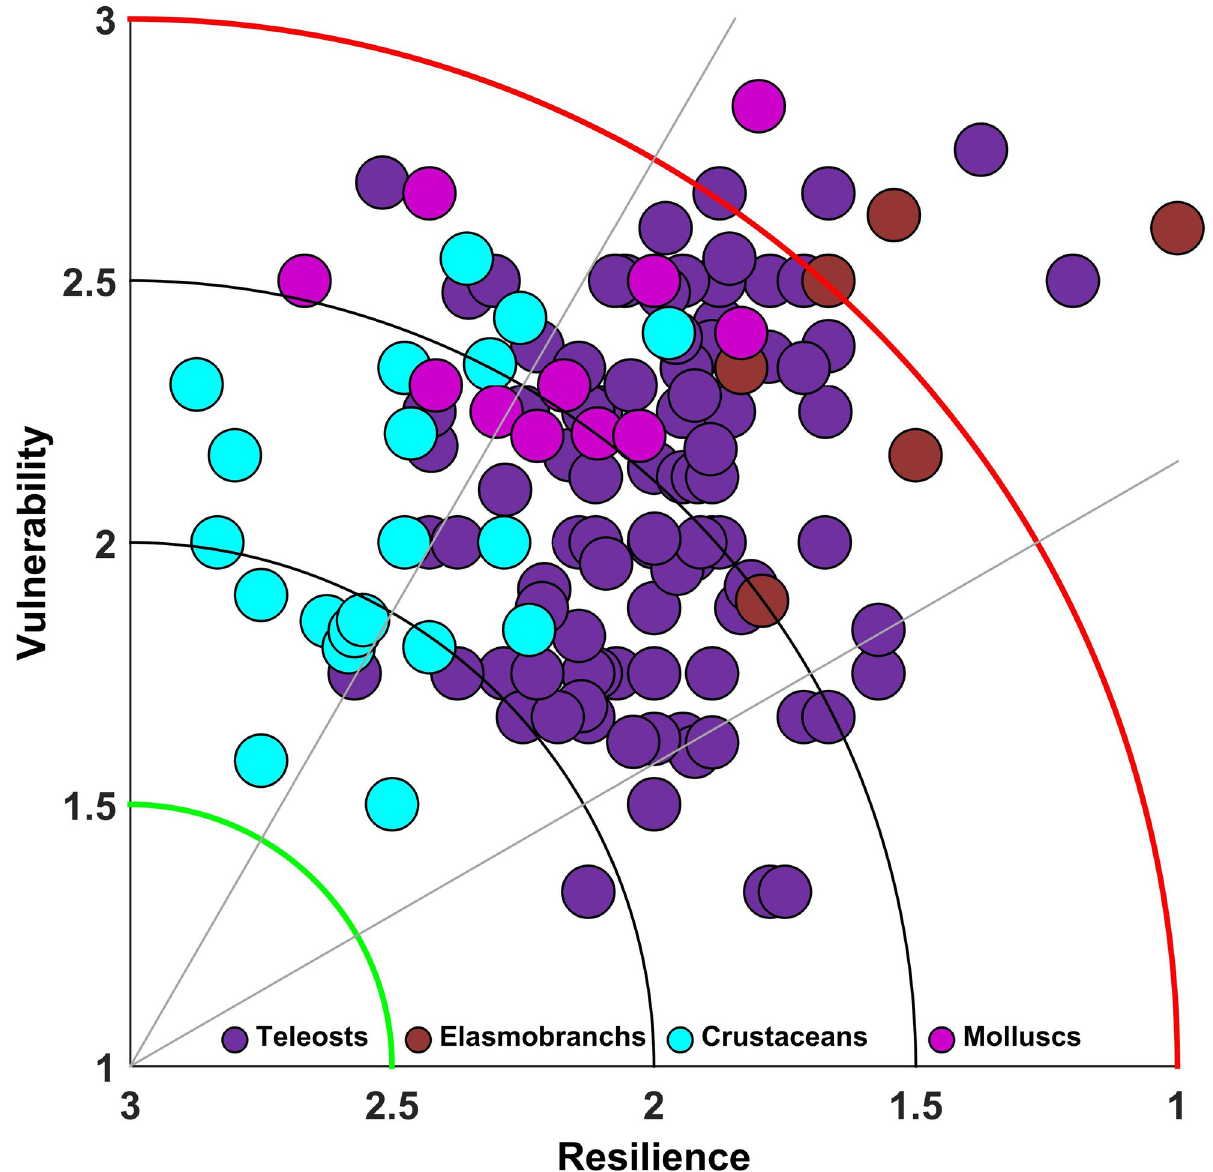
Fig 3. Scatter plot of R-V scores for all 133 species/stocks including 96 teleosts, 6 elasmobranchs, 20 crustaceans and 11 molluscs. ( Scomberomorus lineolatus ) had low resilience and high vulnerability (#84, Fig 4B). All the elasmobranchs assessed had low resilience and high vulnerability (Fig 4C) and the least vulner- ability was observed for the spade nose shark, Scoliodon laticaudus (#101, Fig 4C). Most crustaceans had a resilience score above 2 indicating their relative hardiness (Fig 4D). Crustaceans that showed higher vulnerability were the mud spiny lobster, Panulirus polypha- gus ; penaeid shrimps, Penaeus monodon , P . semisulcatus and Metapenaeus monoceros . Soleno- cerid and palaemonid shrimps such as Solenocera choprai , S . crassicornis and Nematopalaemon tenuipes showed very high resilience and low vulnerability. Unlike crustaceans, molluscs show a shift in the plot towards higher vulnerability, while showing medium resilience (Fig 4E).